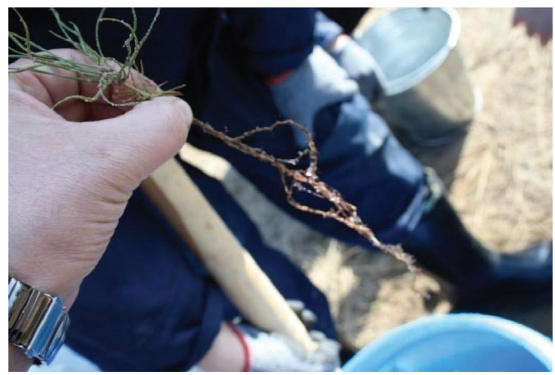
Figure 1: Method of planting-application of hydrogel suspension to the roots of pine